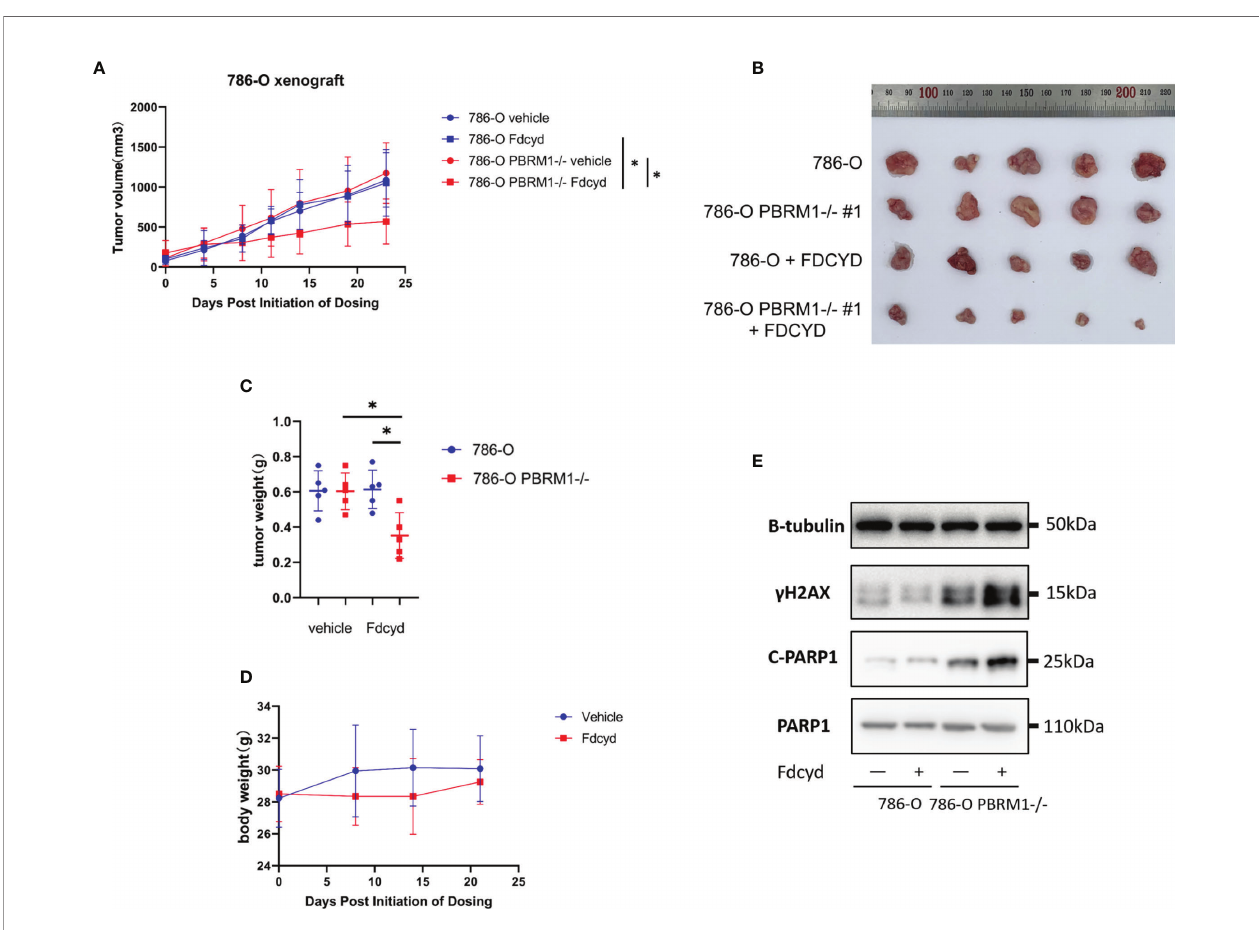
FIGURE 6 | Fdcyd treatment induces synthetic lethality in PBRM1-de fi cient renal cancer in vivo. (A) Mice bearing 786-O or 786-O PBRM1-/- were treated daily with vehicle or Fdcyd with 25 mg/kg using oral gavage throughout the indicated treatment period. Data are mean ± SD. P=0.0111 between 786-O PBRM1-/- vehicle and Fdcyd treatment groups (n = 5), ANOVA. P=0.0251 between 786-O Fdcyd and 786-O PBRM1-/-Fdcyd treatment groups (n = 5), ANOVA. (B) Images of renal tumors excised from tumor-bearing mice. (C) Tumor weights were measured after harvested from the mice. Data are mean ± SD of tumor weights from four mice group (n = 5). *P < 0.05, Mann-Whitney U. (D) Body weight analysis of mice bearing tumor xenografts. (E) Immunoblot analysis illustrating the c-PARP1 and g H2AX protein levels in 786-O PBRM1+/+ and PBRM1 − / − tumor tissues.